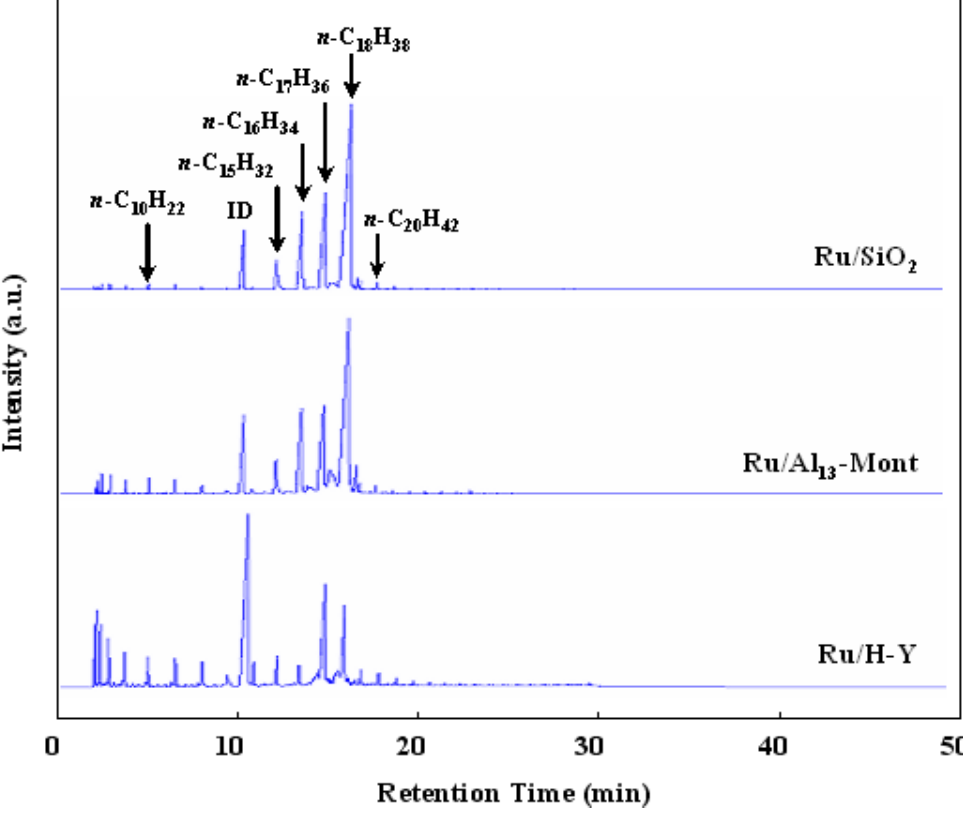
) formed from the 5+